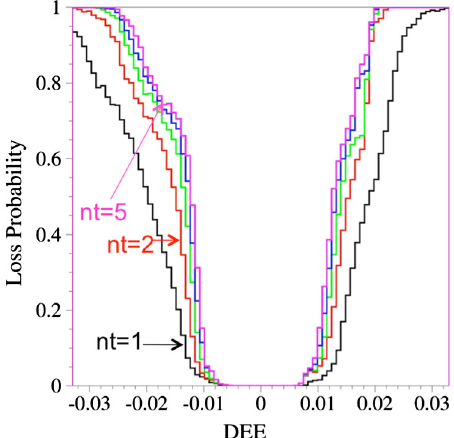
FIG. 5. (a) IR loss particles distribution for the KLOE crab- waist optics, with scrapers at their experimental set. (b) Trajectories with hit positions on the physical aperture that the particles actually